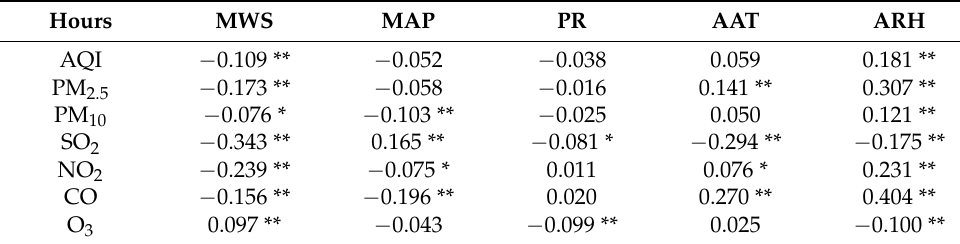
Table 7. Correlations between air quality and meteorological